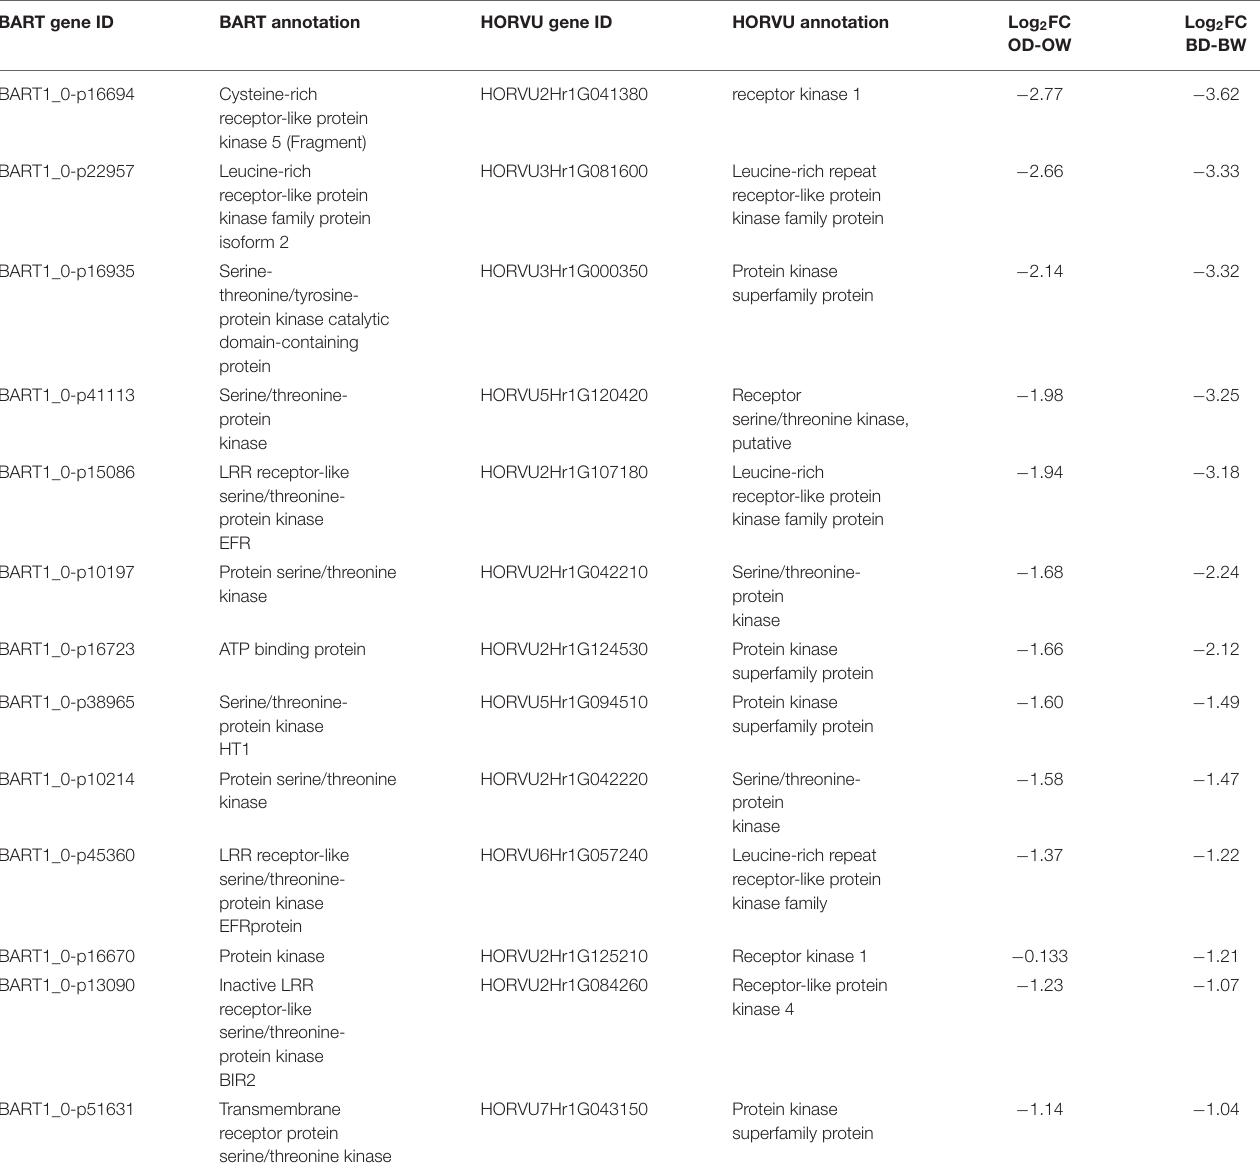
TABLE 4 | The BART and HORVU annotations of the common down-regulated genes in barley plants under drought stress. BART gene